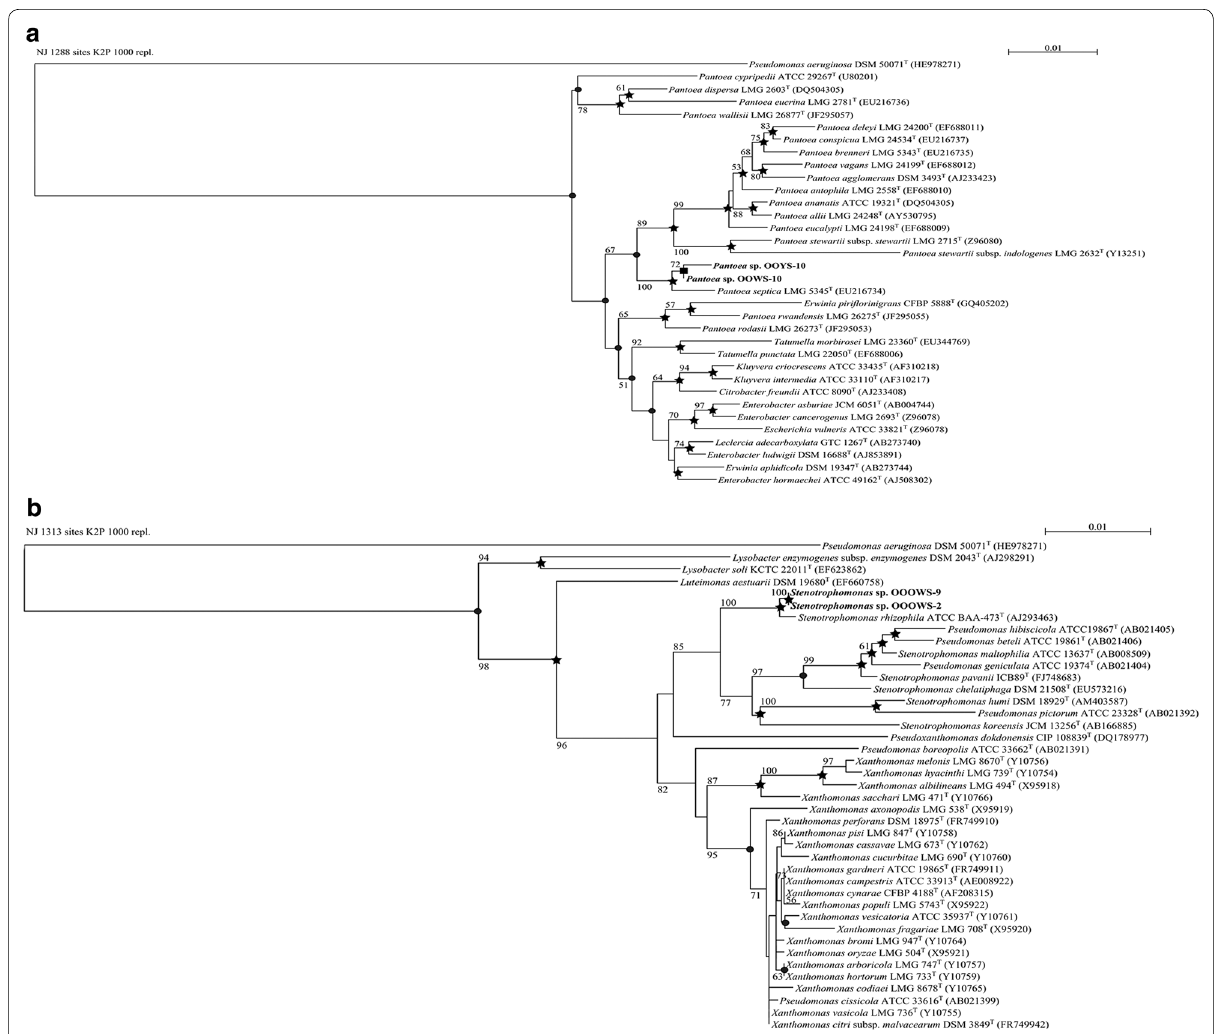
Fig. 1 NJ phylogenetic tree based on 16S rRNA gene sequences showing the taxonomical positions of Pantoea septica strains OOWS-10 and OOYS-10 ( a ) and Stenotrophomonas spp. OOOW-2 and OOOW-9 ( b ) with respect to their closely related reference strains. Bootstrap values (expressed as percentages of 1000 replicates) of 50% are shown at branch points. Filled circle, filled square, star indicate that the corresponding ≥ nodes were also recovered in trees constructed using MP, ML, and both algorithms, respectively. Pseudomonas aeruginosa DSM 50071 T was used as an outgroup. Bar, 0.01 substitutions per nucleotide